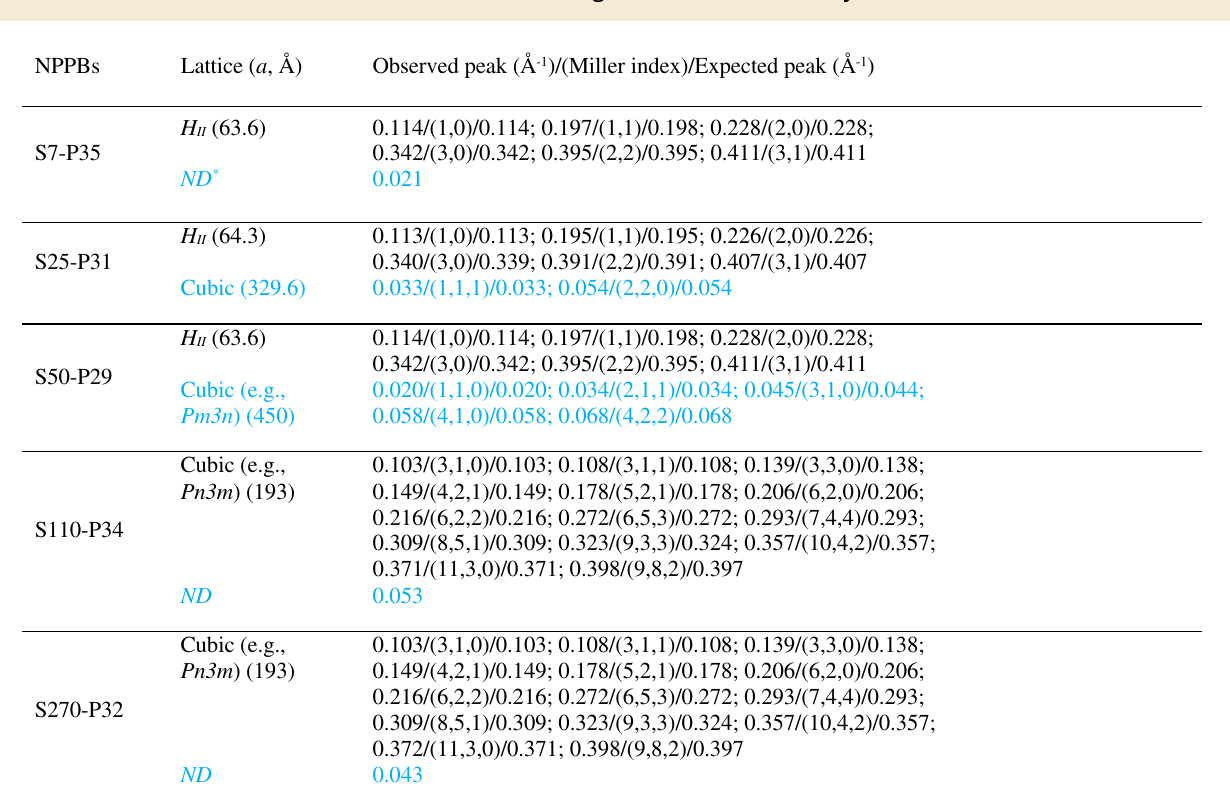
Table 3 SAXS reveals ordered structures in bacteria-mimicking membrane remodeled by